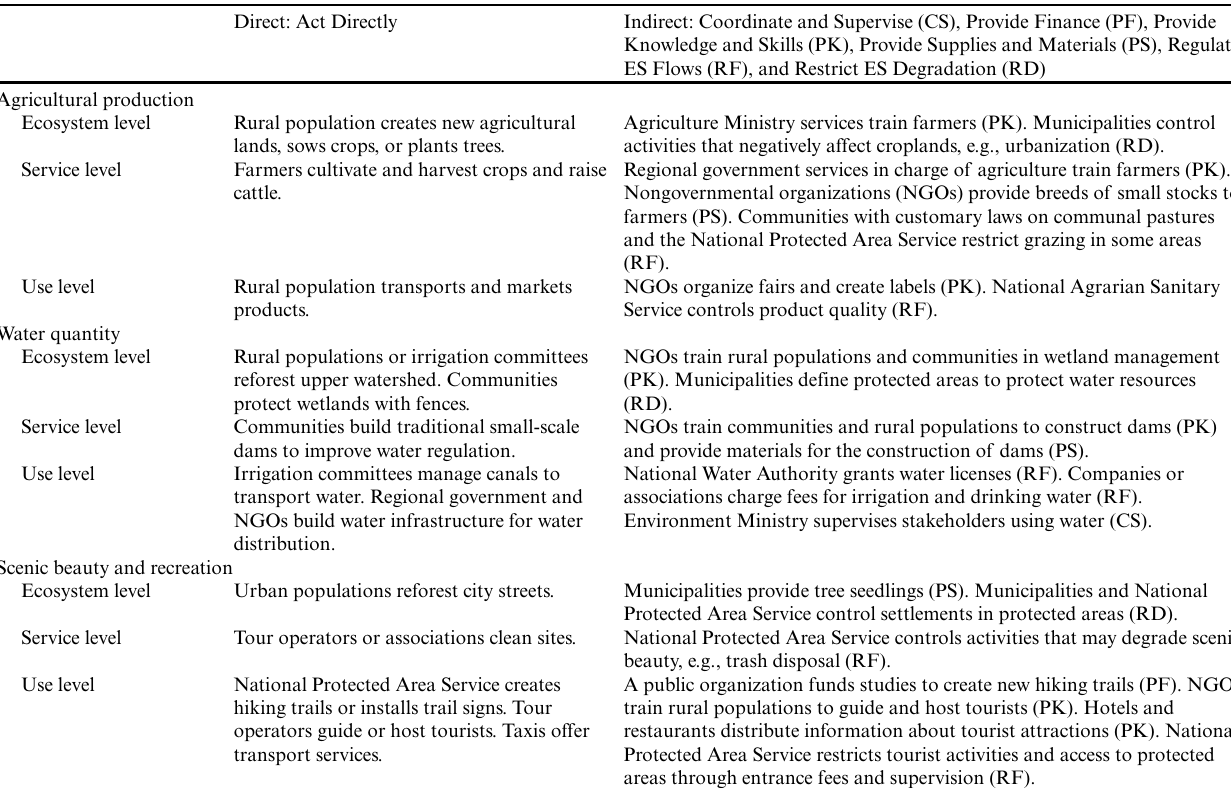
Table 3 . Examples of management activities for three ecosystem services (ESs) at the study site. Direct: Act Directly Indirect: Coordinate and Supervise (CS), Provide Finance (PF), Provide Knowledge and Skills (PK), Provide Supplies and Materials (PS), Regulate ES Flows (RF), and Restrict ES Degradation (RD) Rural population creates new agricultural lands, sows crops, or plants